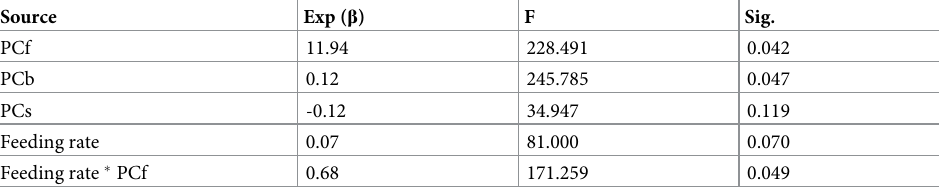
Table 2. GLM on factors affecting nestling development and the estimate values of parameters.